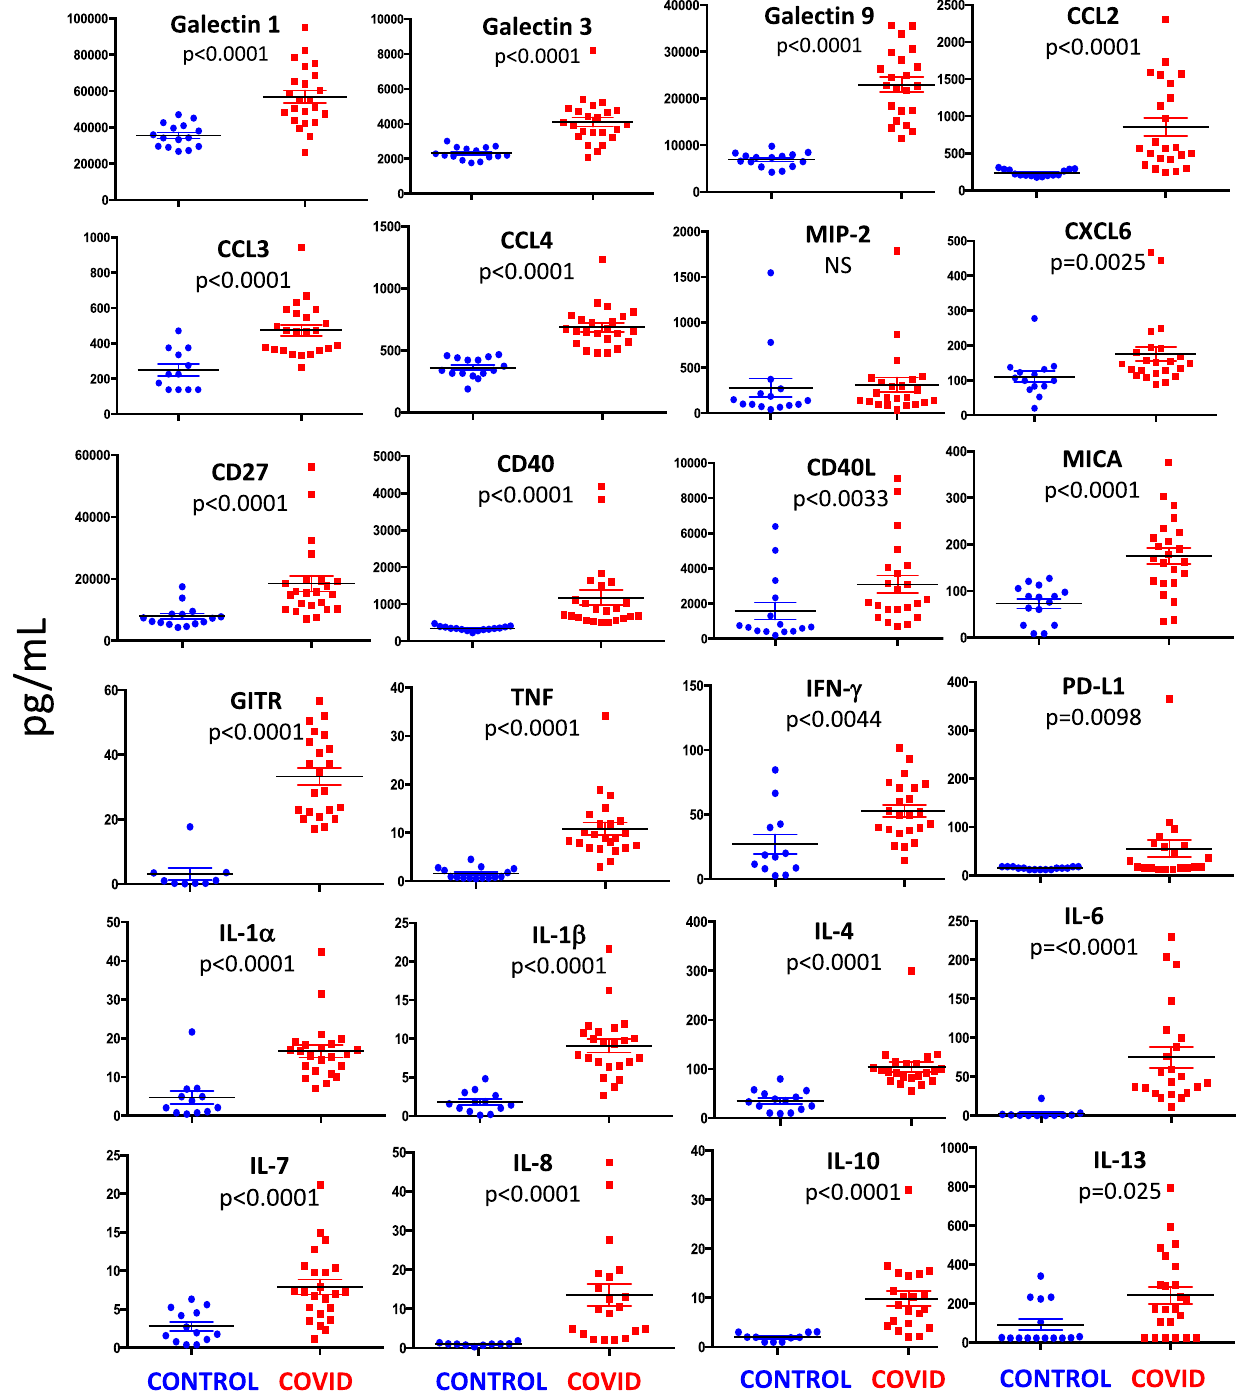
Fig. 7 Plasma level of cytokines and chemokines from COVID-19 patients and controls. Quanti fi cation of cytokines and other mediators in plasma obtained from COVID-19 patients ( n = 23) and healthy controls ( n = 15). Data represent individual values, mean (centre bar) ± SEM (upper and lower bars). Statistical analysis by two-sided Mann – Whitney nonparametric test; if not indicated, p value is not signi fi cant. Source data are provided as a Source Data fi